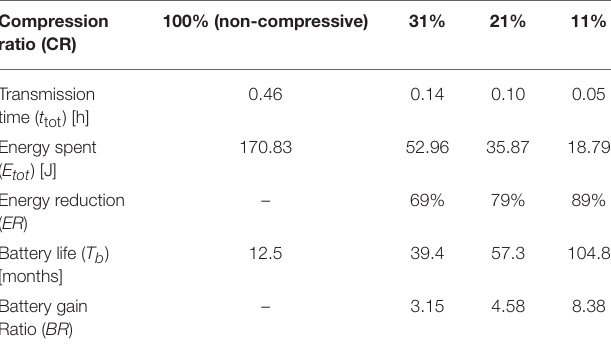
TABLE 4 | Daily sensor energy consumption and battery lifetime gains due to wireless data transmission for various CRs. Compression ratio